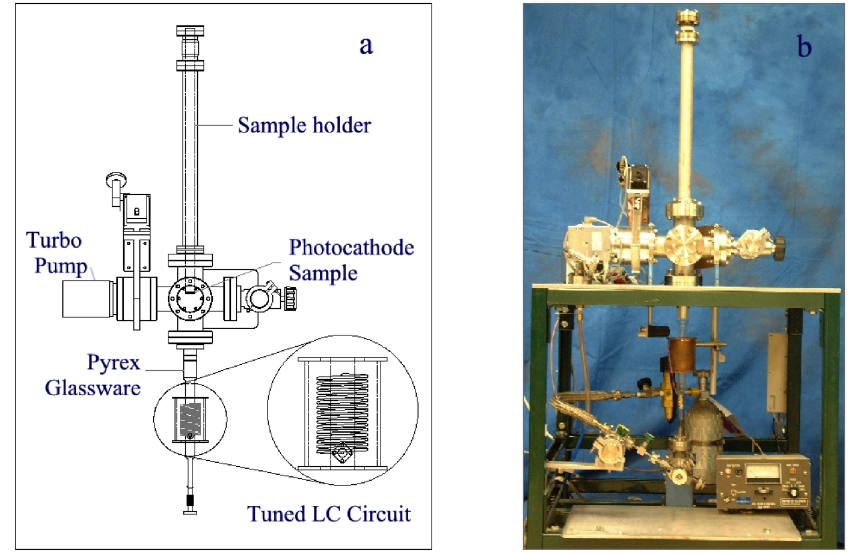
FIG. 12. (Color) The atomic hydrogen/deuterium source used to clean photocathodes prior to installation in the